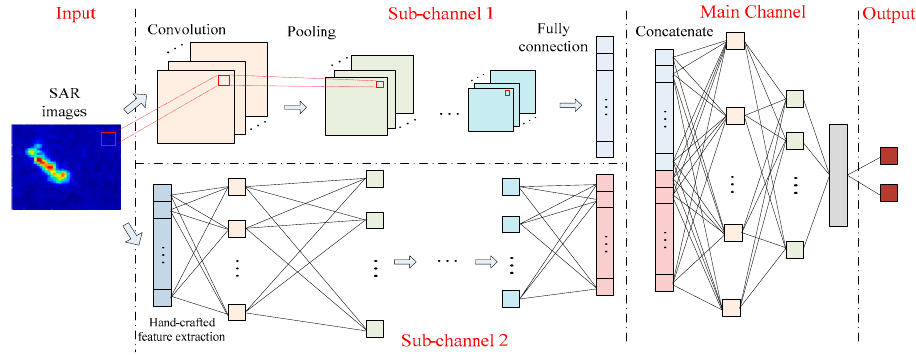
Figure 15. Structure of target detection model with multi ‐ features in SAR images.